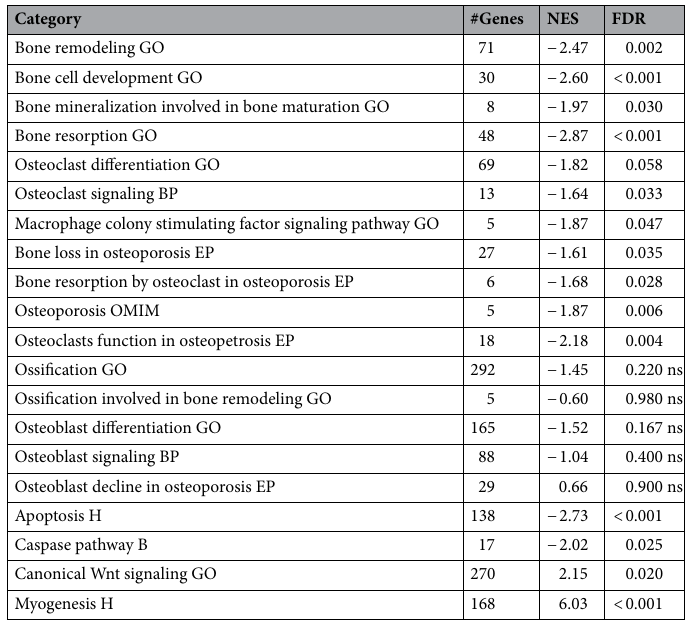
Table 1. Gene set enrichment for selected Gene Ontology (GO) biological processes, Biocarta (B), Hallmark (H), BioPlanet (BP), OMIM and Elsevier Pathway gene sets involved in bone homeostasis in bone of black bears during hibernation. Positive NES (normalized enrichment score) values indicate elevated proportion of overexpressed genes and negative scores indicate excess of under expressed genes during hibernation relative to summer. FDR is the false discovery